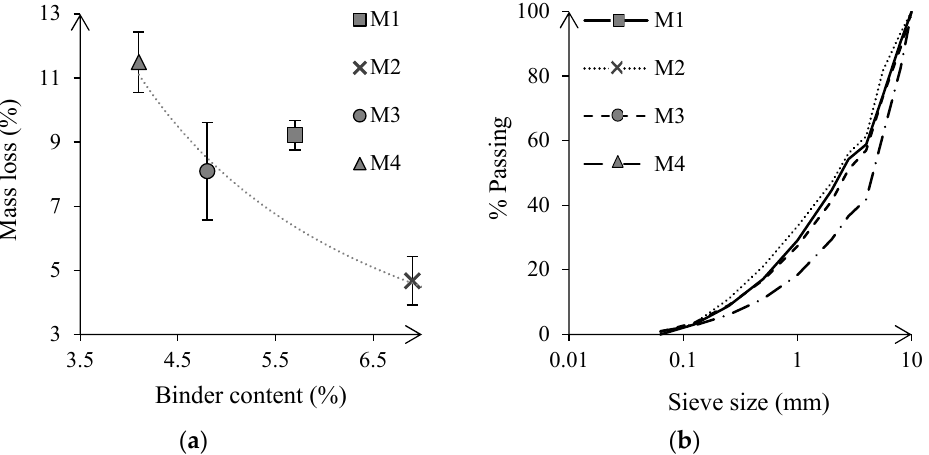
Figure 7. Results from the Cantabro test: ( a ) Percentage of mass loss and ( b ) aggregate gradation of the lost aggregates.